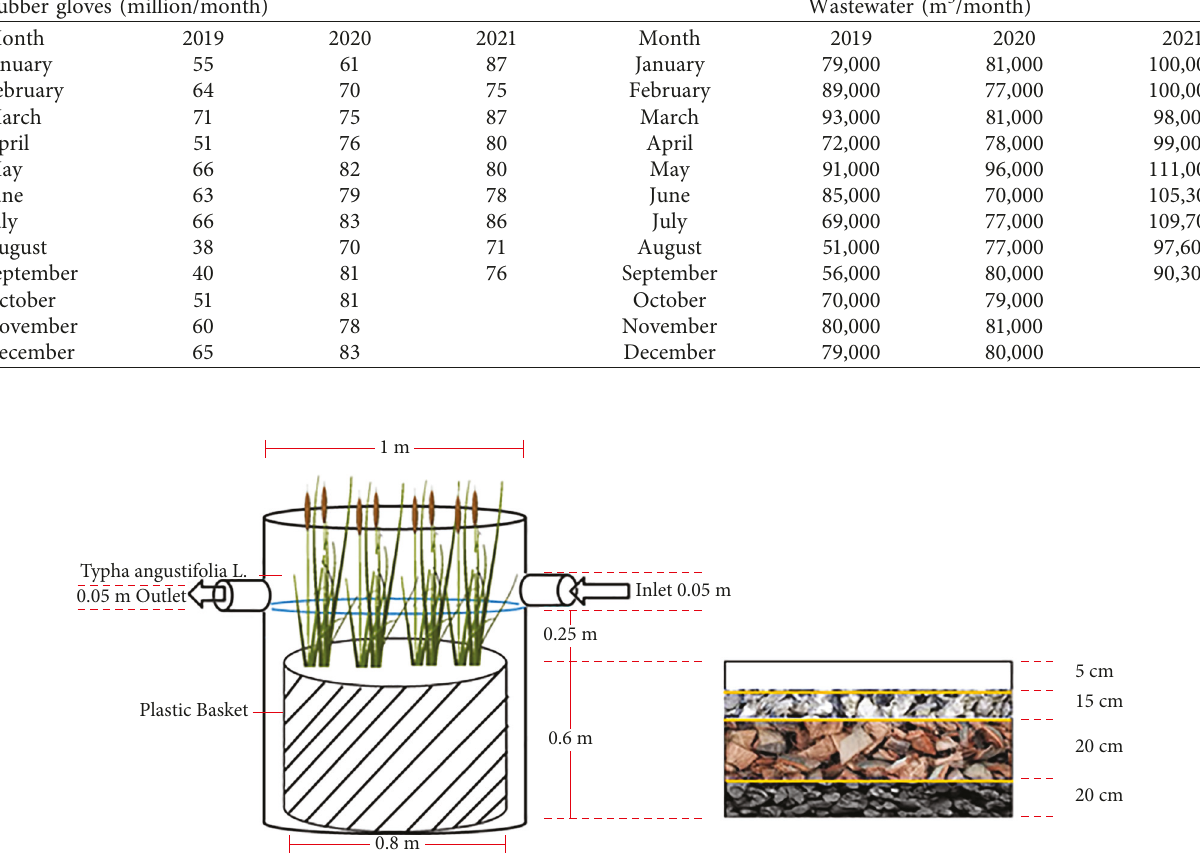
Figure 1: Schematic diagram of pilot-scale HSFCWs planted with emergent Typha angustifolia L.